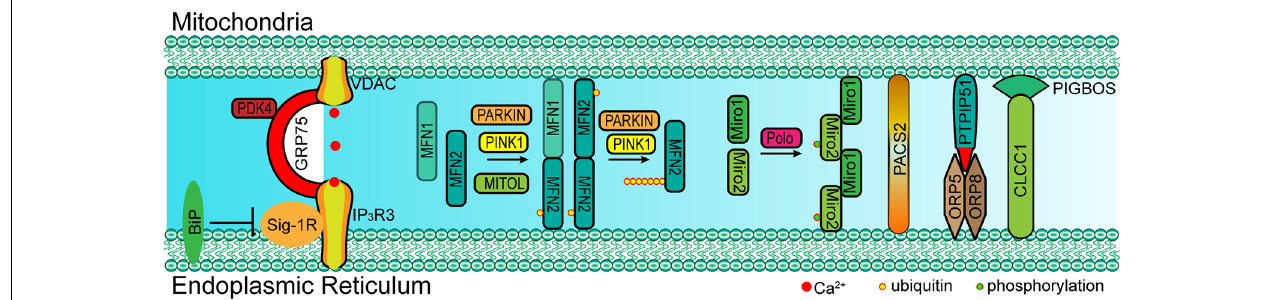
FIGURE 2 | Paradigm of molecular determinants in ER-mitochondria tethering in mammal. Left: GRP75 interacts with both VDAC (located at OMM) and IP 3 R3 (located at MAM) to form a complex that mediates the ER-mitochondria contact. The interaction between Sig-1R and IP 3 R3 promotes the stability of IP 3 R3, which is essential for the IP 3 R3-GRP75-VDAC complex, while BiP inhibits this interaction by competitive binding to Sig-1R. Middle: MFN1/2 form a dimer at MAM and mediate ER-mitochondria tethering. PARKIN, PINK1 and MITOL mediate the mono-ubiquitination of MFN2 and promote MFN2 translocation to MAM. However, the poly-ubiquitination of MFN2 mediated via PARKIN and PINK1 leads to the tethering disruption. Right: Miro1/2 form a cluster at MAM and mediate ER-mitochondria tethering, and the phosphorylation of Miro2 by polo kinase is essential for the formation of the Miro cluster. Cytosolic PACS2 recruits to the MAMs and OMM to mediate ER-mitochondria membrane contact. The OMM-resident PTPIP51 interacts with ORP5/8 at MAM to maintain mitochondrial morphology and respiratory functions. The OMM-resident PIGBOS interacts with the ER membrane protein CLCC1 to maintain ER–mitochondrial contact. GRP75, 75 kDa glucose-regulated protein; VDAC1/2, voltage-dependent anion-selective channel protein; IP 3 R3, inositol 1,4,5-trisphosphate receptor type 3; MFN1/2, mitofusin-1/2; Sig-1R, sigma-1 receptor; ORP5/8, oxysterol-binding protein (OSBP)-related proteins 5/8; PTPIP51, protein tyrosine phosphatase interacting protein-51; CLCC1, chloride channel CLIC-like protein 1; PIGBOS, PIGB opposite strand 1; PACS2, phosphofurin acidic cluster sorting protein 2; Miro1/2, mitochondrial Rho 1/2; MITOL: mitochondrial ubiquitin ligase; PINK1, PTEN-induced putative kinase protein